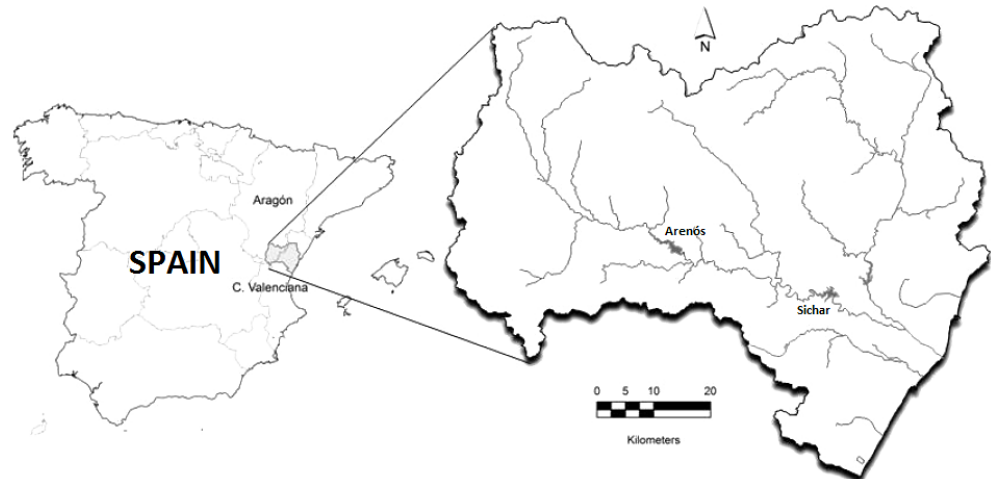
Figure 2. Mijares River basin location (eastern Spain).